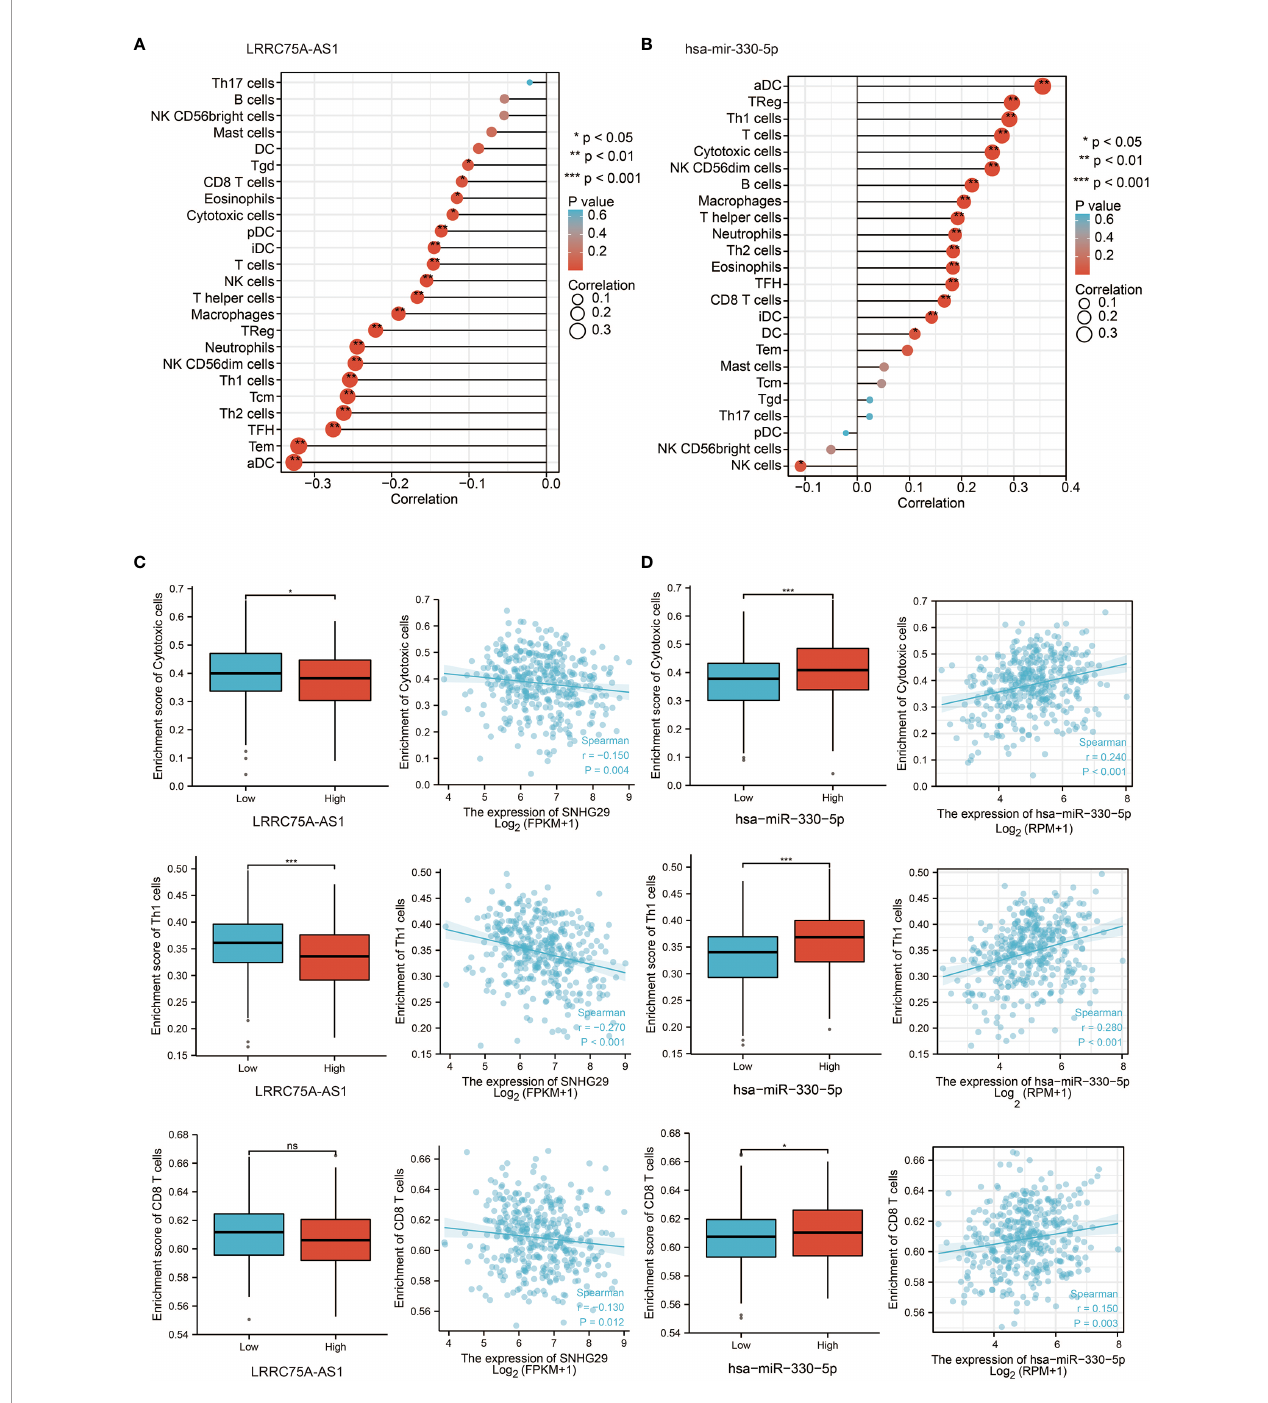
FIGURE 5 | LRRC75A-AS1 and has-mir-330-5p are correlated with immune cell in fi ltration in OC. (A) Correlation between the relative abundances of 24 immune cells and LRRC75A-AS1 expression level in OC of the TCGA cohort. The size of dots shows the absolute value of Spearman R. (B) Correlation between the relative abundances of 24 immune cells and has-mir-330-5p expression level in OC of the TCGA cohort. The size of dots shows the absolute value of Spearman R. (C) Scatter plots and correlation diagrams showing the difference of cytotoxic cells, Th1/2 cells, and CD8 + T cells in fi ltration level between LRRC75A-AS1-high and LRRC75A-AS1-low groups. The p values were calculated using the Student t-test: ns as nonsense, *P < 0.05, **P < 0.01, ***P < 0.001, ****P < 0.0001. (D) Scatter plots and correlation diagrams showing the difference of cytotoxic cells, Th1/2 cells, and CD8 + T cells in fi ltration level between has-mir-330-5p-high and has-mir- 330-5p-low groups. The p values were calculated using the Student t-test: ns as nonsense, *P < 0.05, **P < 0.01, ***P < 0.001, ****P <